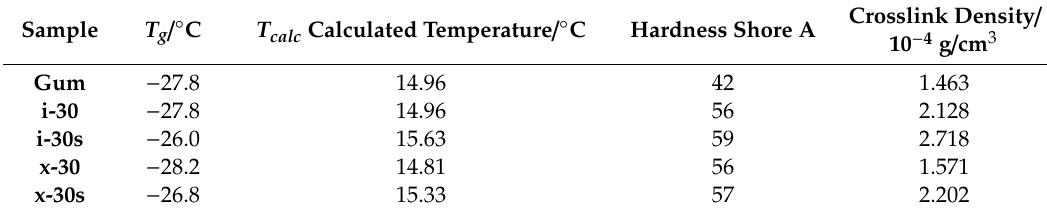
Table 1. Glass transition temperatures of elastomer compounds and the calculated temperatures for the friction measurement by using the WLF principle.